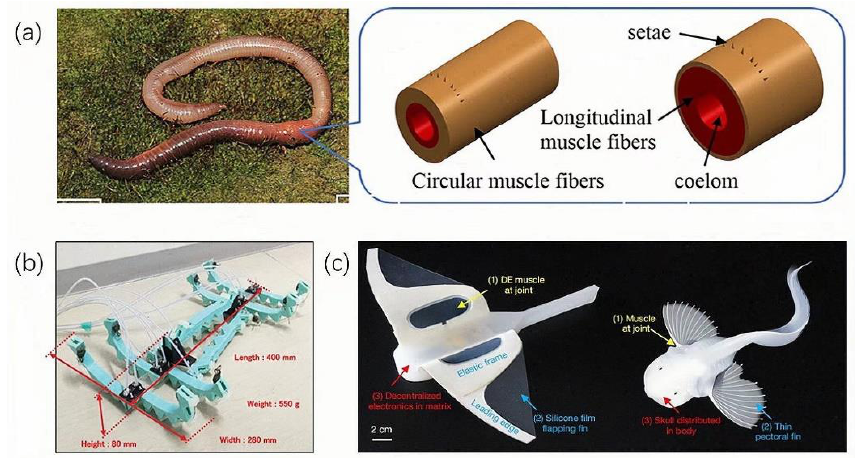
Figure 2. ( a ) The diagram of earthworm body structure [26]. ( b ) TAOYAKA-S II [27]. ( c ) An un- tethered soft robot [28]. un-tethered soft robot